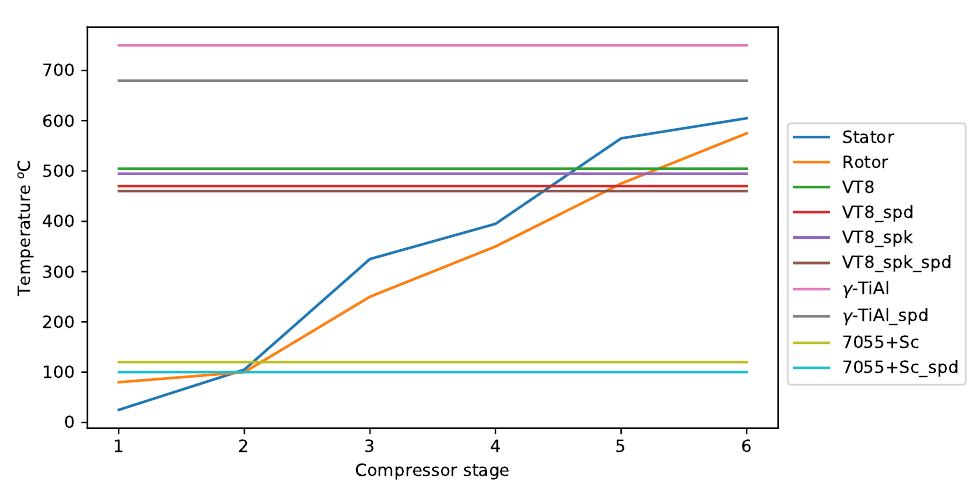
Figure 9. Material maximum temperature vs the operating temperature of compressor stages.